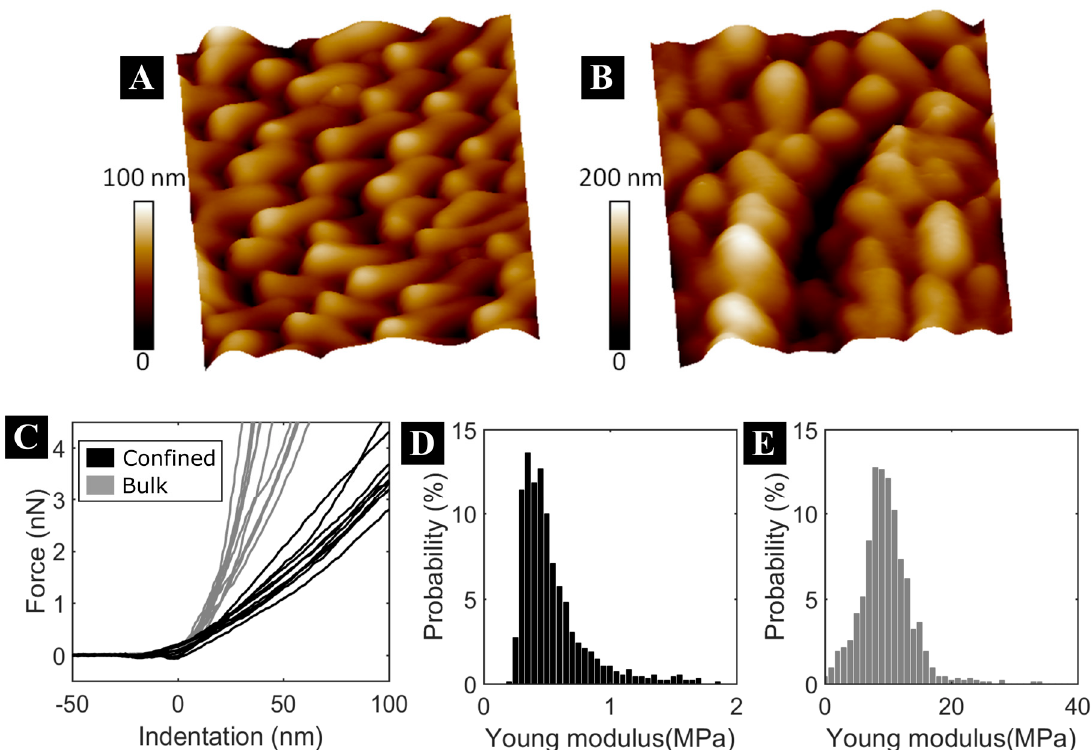
Figure 3. ( A – B ) In-situ atomic force microscopy (AFM) three-dimensional topography images (2.5 µm × 2.5 µm) of free nanopillars of the copolymer synthesized in confinement in a dry environment ( A ) and an aqueous environment ( B ). ( C ) Typical AFM force vs. indentation curves for free copolymer nanopillars (black) and bulk films (gray). ( D – E ) Young’s Modulus ( E ) histograms from N > 900 force curves of copolymers synthesized in confinement ( D , E = 0.54 ± 0.26 MPa) and in bulk ( E , E = 9.9 ± 5.8 MPa), standard deviations taken as error. Horizontal scales are different as they were optimized for each distribution.